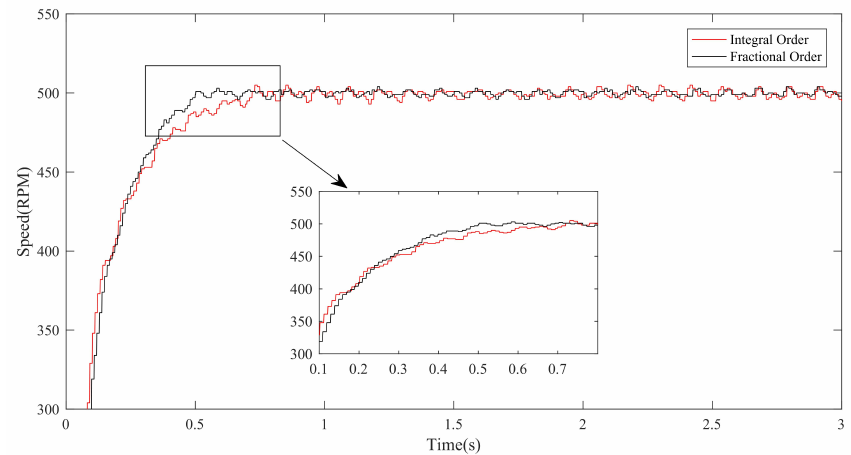
Figure 8. The response curves at middle speed.